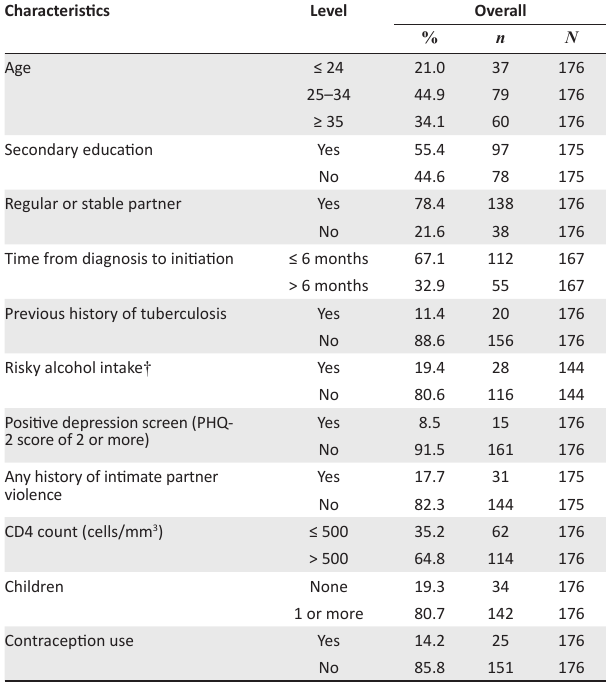
TABLE 1 : Baseline characteristics of women with cervical smear results available ( N = 176).